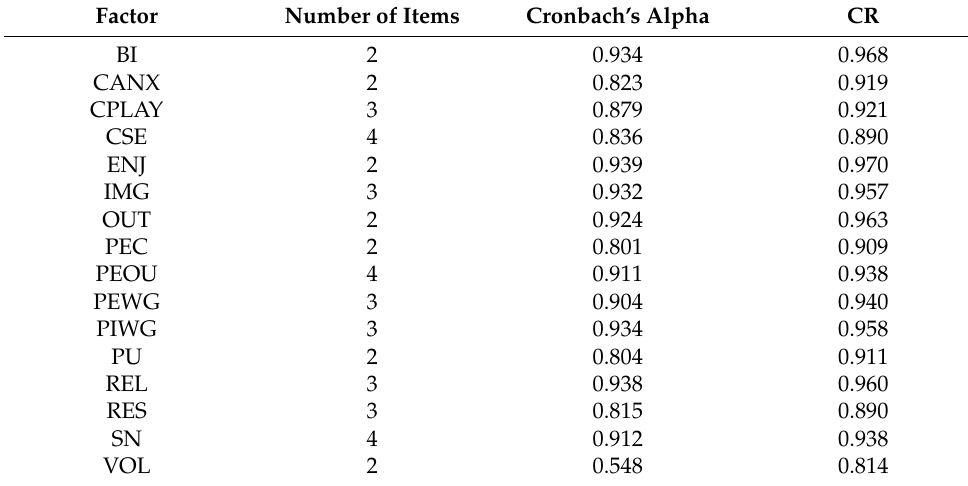
Table 3. Summary of Reliability